Question: Briefly state, in one sentence, what is plotted here.
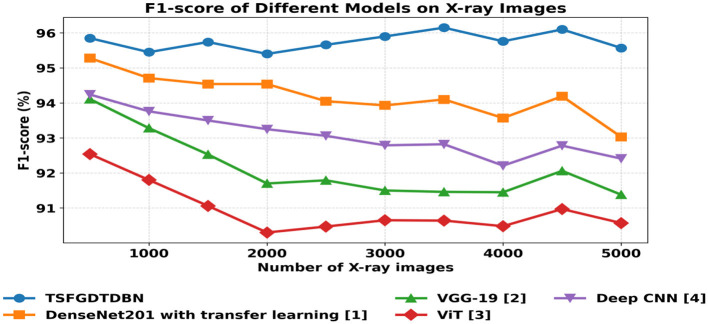
Answer: Performance analysis of F1-score using Multi-Class Knee Osteoporosis X-Ray Dataset.